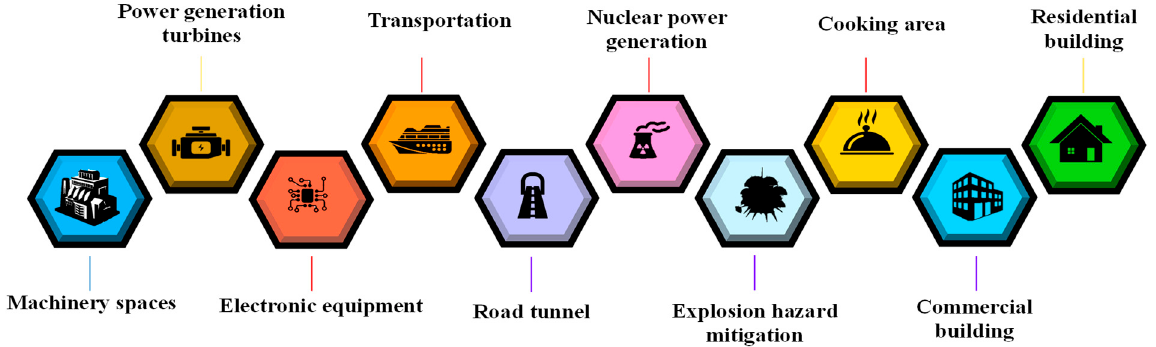
Figure 7. Common applications of water mist